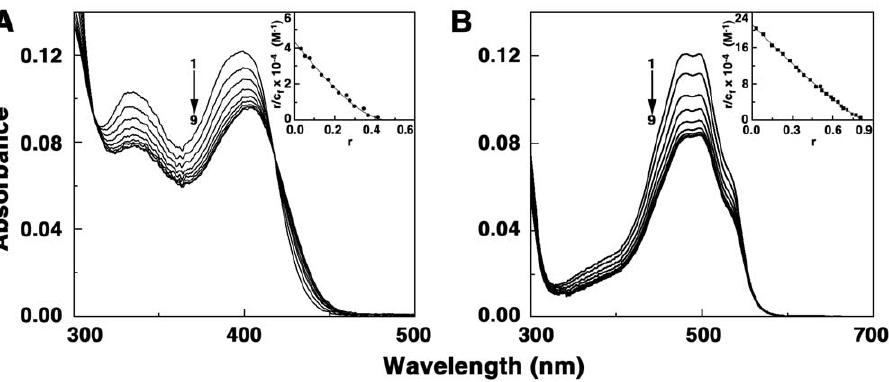
Figure 2. Absorption spectral titration of drugs with tRNA. (A) ADG (11 m M) treated with 0, 55, 110, 165, 220, 330, 440, 550 and 660 m M (curves 1–9) of tRNA and (B) DAU (10.4 m M) treated with 0, 20.8, 52, 83.2, 124.8, 166.4, 208, 312 and 364 m M (curves 1–9) of tRNA. Inset: representative Scatchard plot of each complexation. The solid lines represent the non-linear least square best fit of the experimental points to the neighbour exclusion model.